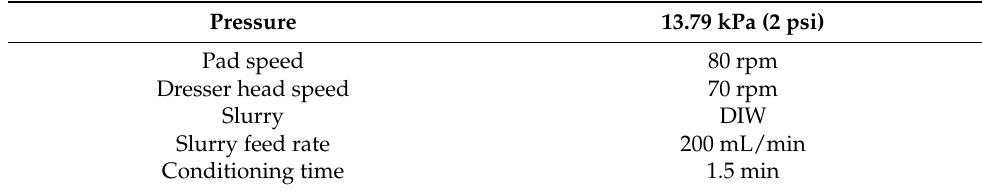
Table 3. Diamond conditioning parameters of pad. Table 2. Break-in parameters of pad dressing.